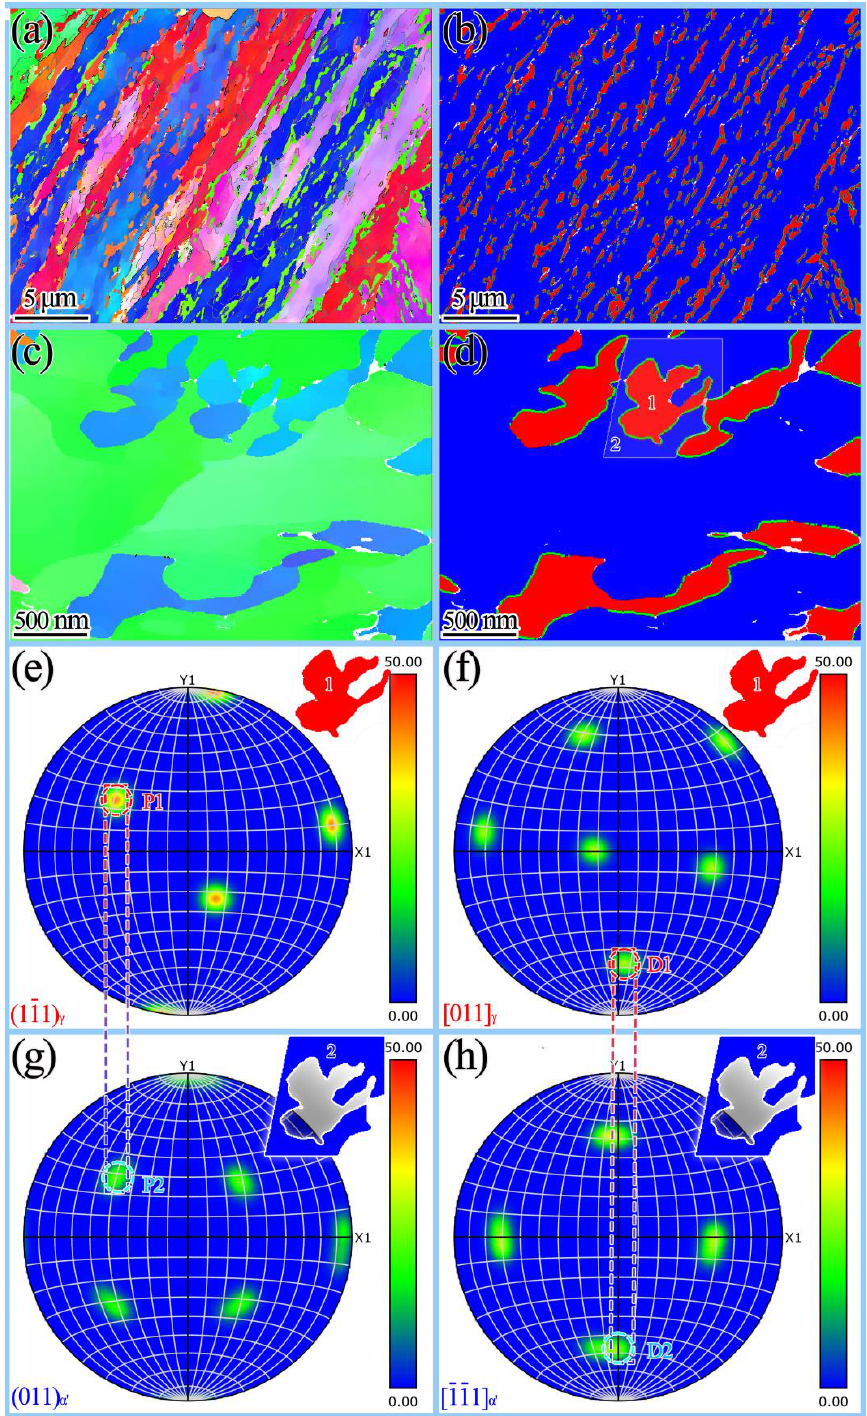
Figure 5. Crystallographic orientation relationship assay of two phases by TKD for the sample tempered at 675 °C (3 h) + 600 °C (2 h): ( a ) IPF; ( b ) K-S orientation relationship of the martensite and reversed austenite phase (martensite in blue and austenite in red); ( c ) IPF (high amplification); ( d ) K-S orientation relationship of the martensite and reversed austenite phase (high amplification, martensite in blue and austenite in red); ( e – h ) the pole figures of reversed austenite and martensite.